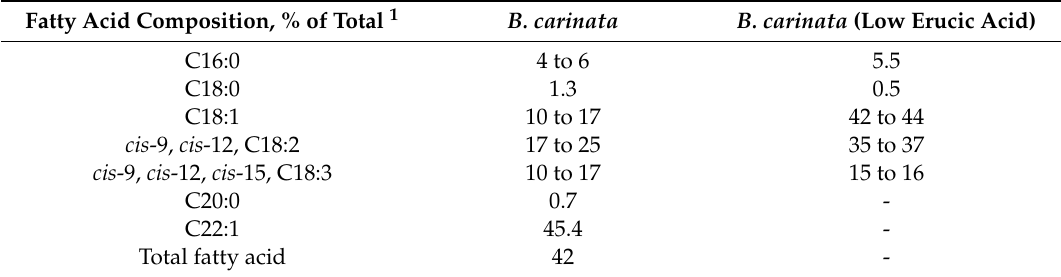
Table 6. Brassica carinata seed fatty acid